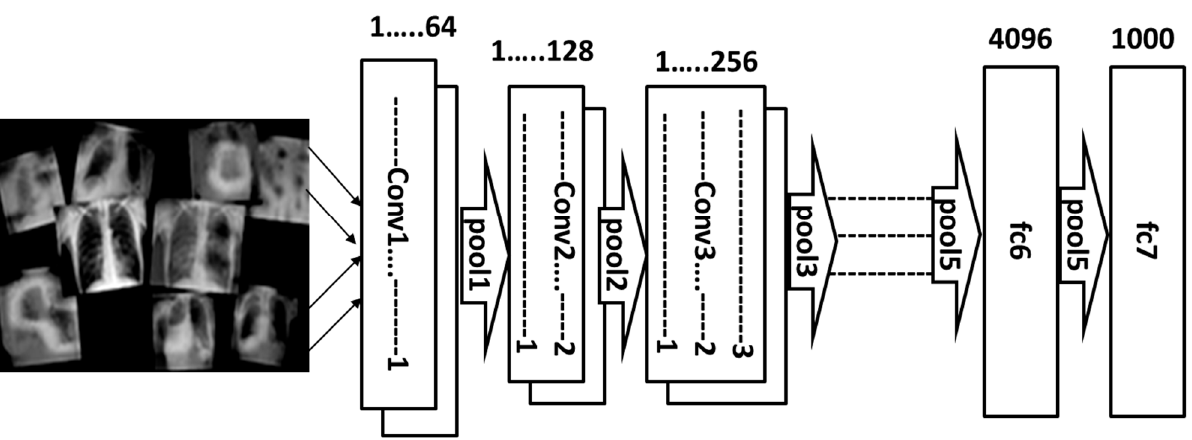
Figure 3. VGG Figure 3. VGG NET.